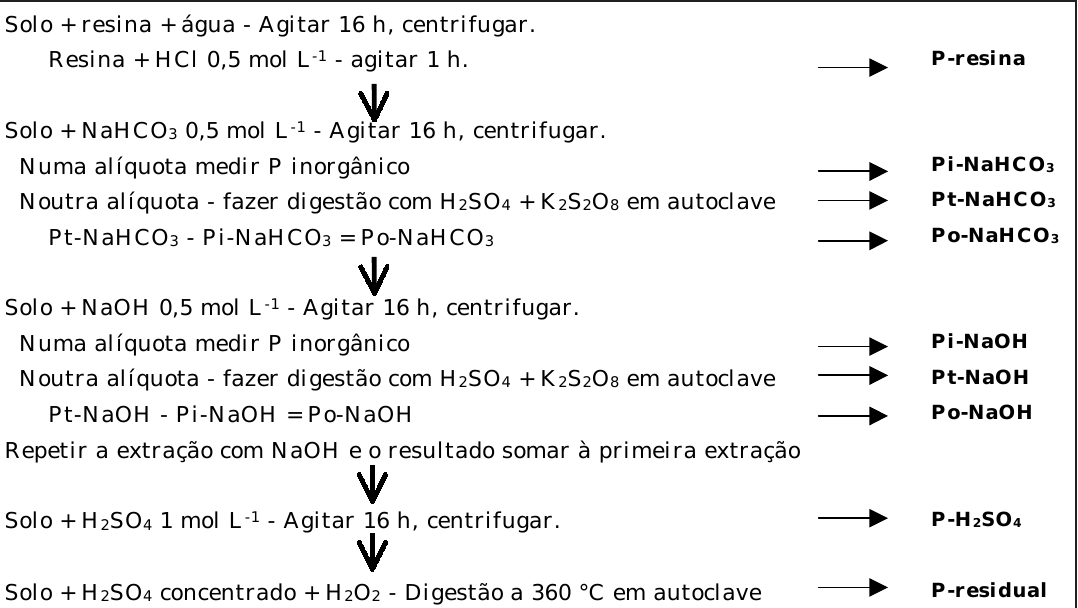
Solo + resina + água - Agitar 16 h,